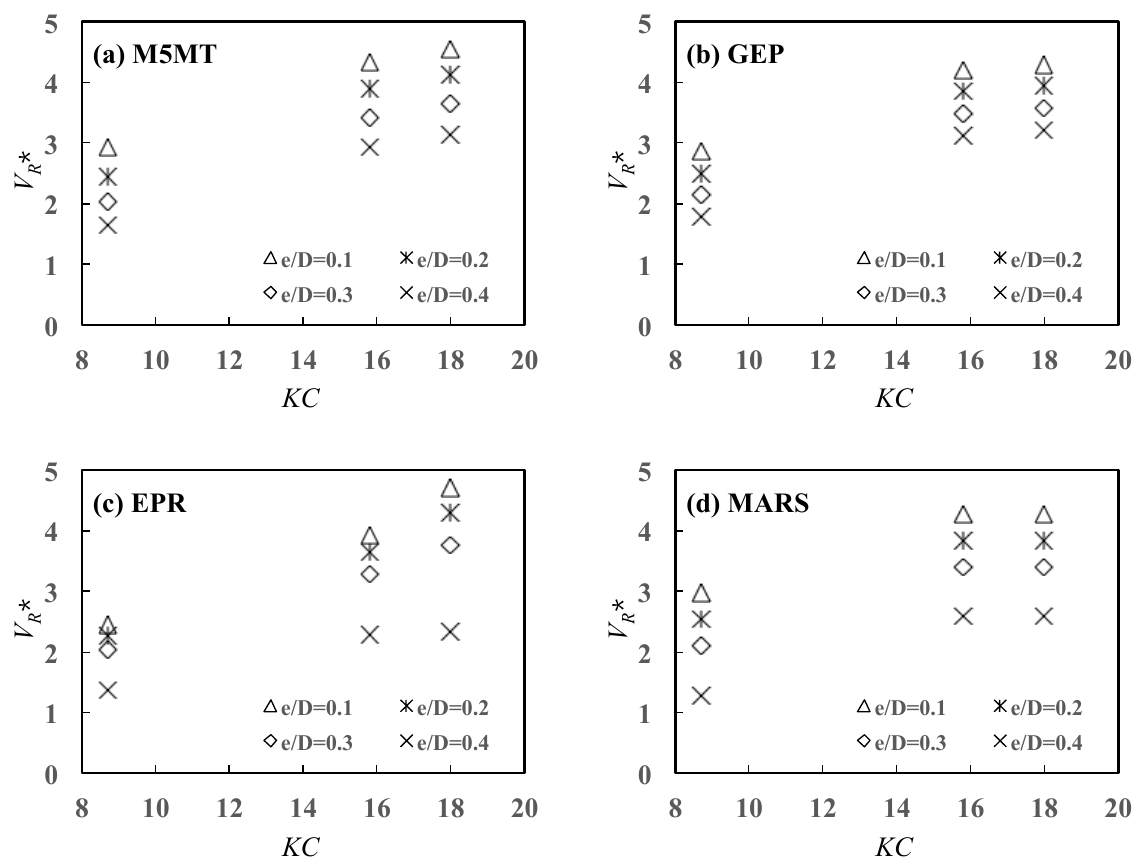
Figure 10. Variations of 𝑉 𝑅∗ against KC at 𝑒 𝐷⁄ from 0.1 to 0.4 and α = 0° for: ( a ) M5MT, ( b ) GEP, ( c ) EPR, and ( d ) MARS.